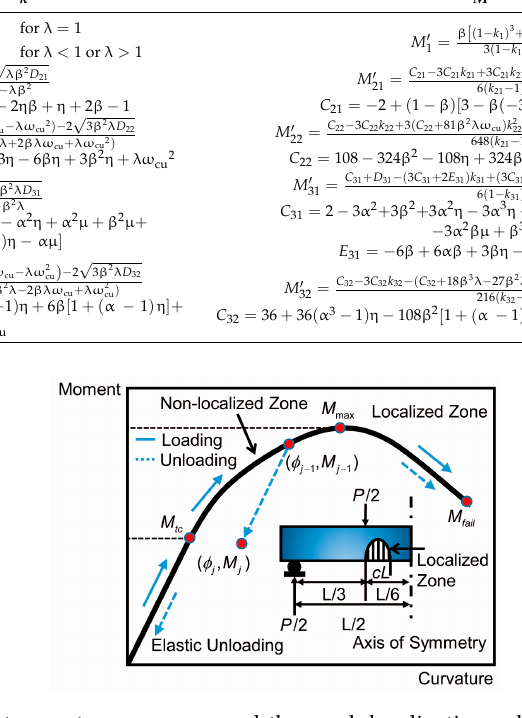
Figure 6. The moment-curvature response and the crack localization rules. Inset: schematic of a four- point bending test (only left half of the model is shown). four-point bending test (only left half of the model is